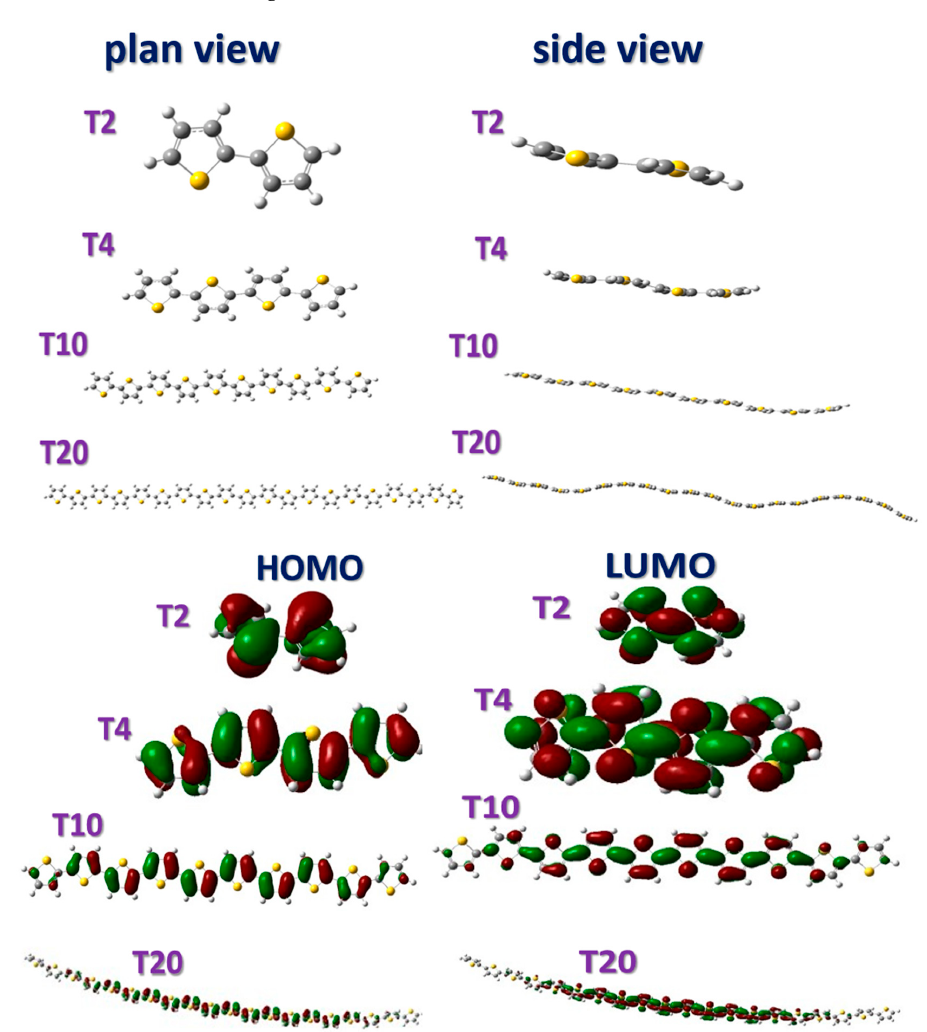
Figure 3. Planar view and side view of optimized molecular structure and orbital diagram of HOMO and LUMO of T2, T4, T10, and T20.